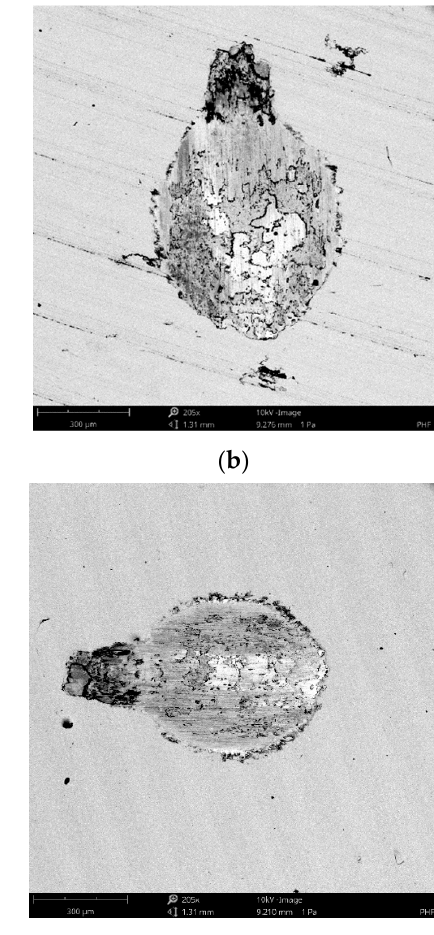
Figure 9. Isometric views of disc surfaces and profiles orthogonal to wear scars at a normal load of 50 N, ( a ) milled sam- ple, ( b ) burnished samples for pressure of 10 MPa, ( c ) 20 MPa, ( d ) 30 MPa, a©( e ) 40 MPa.